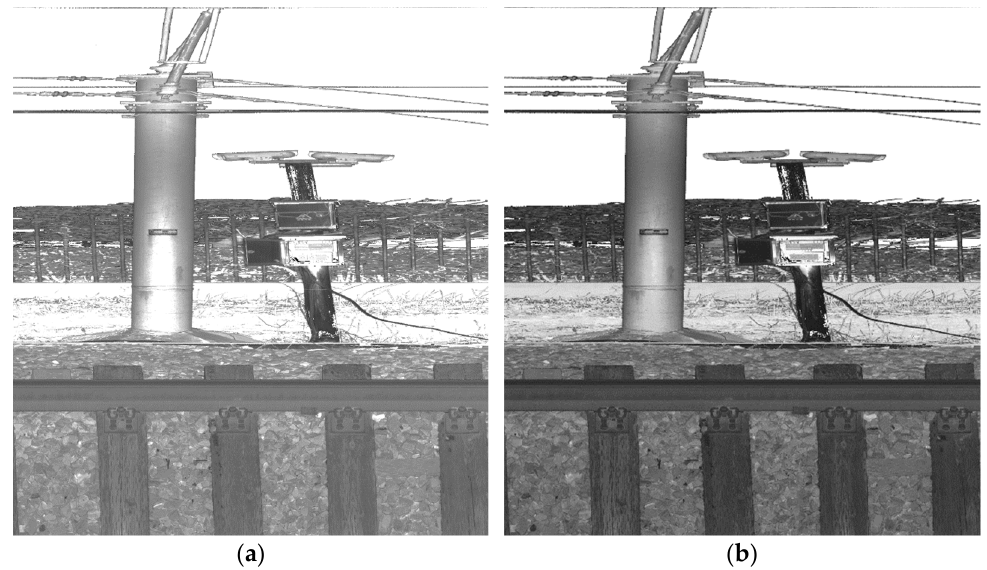
Figure 4. Intensity image generated from partial railway point cloud data: ( a ) Before intensity filtering; ( b ) After intensity filtering.